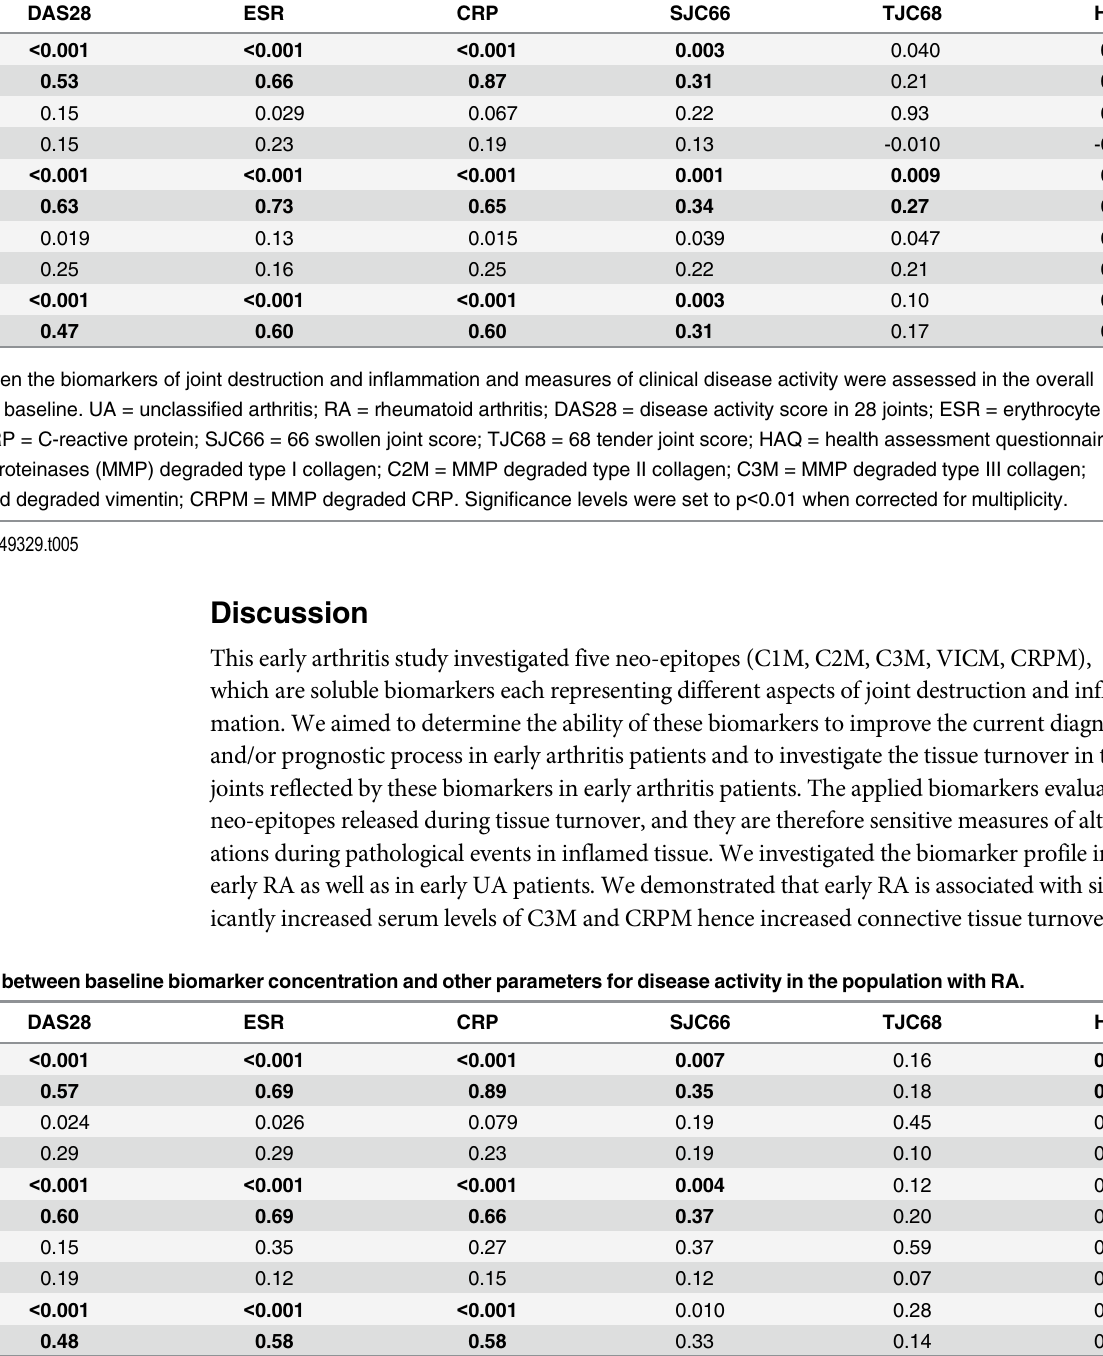
Table 5. Correlations between baseline biomarker concentration and other parameters for disease activity in the overall population (UA+RA). DAS28